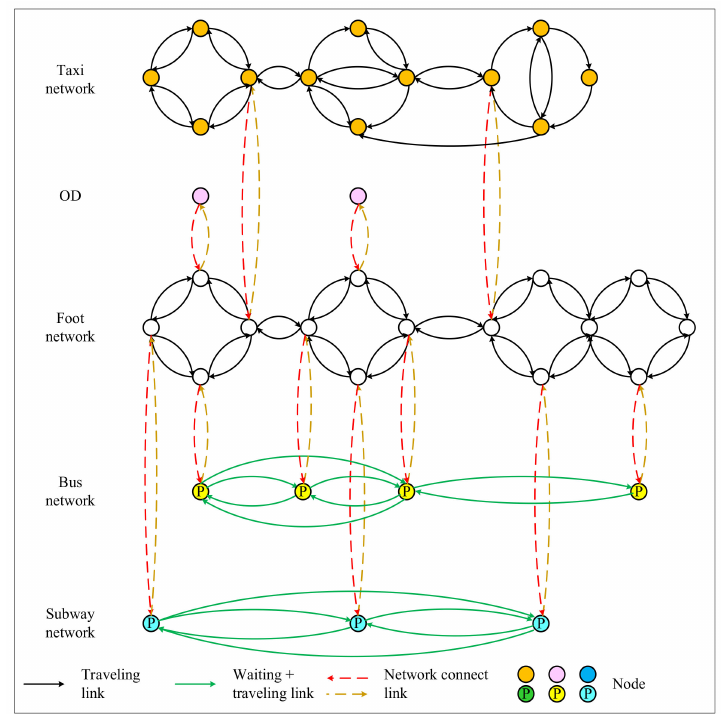
Figure 3. A data-based multimodal super network.